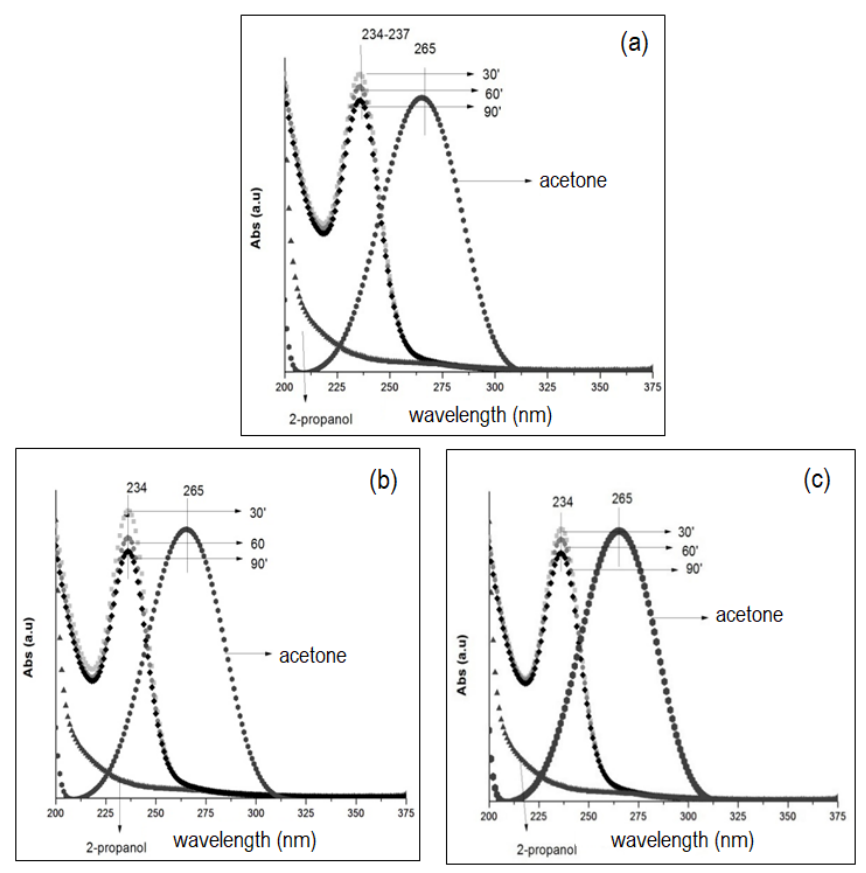
Figure 9: The absorbance of 2-propanol and its produced solution after 30, 60, 90 minutes degradation with ZnS/C under 300 nm (a), and TiO -ZnS/C under 300 nm(b) and 380 nm (c) of light 2